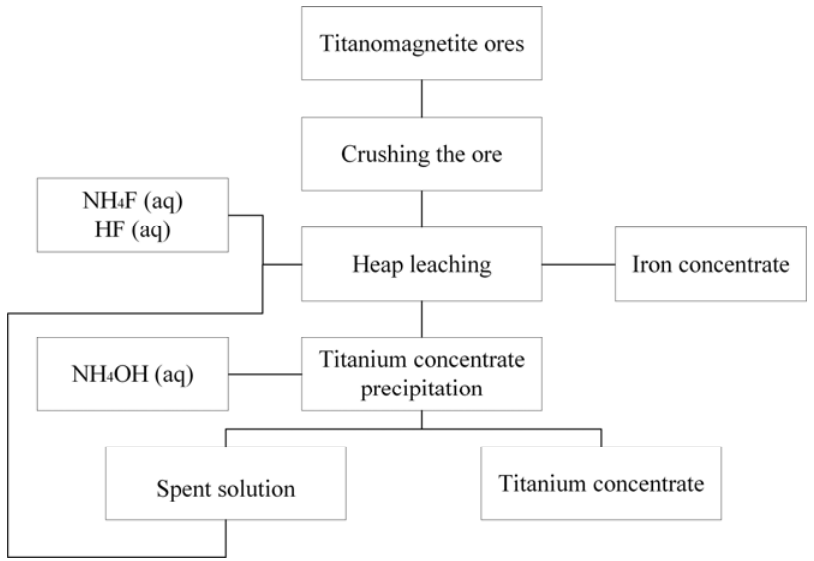
Figure 10. Processing schematic diagram for titanomagnetite.